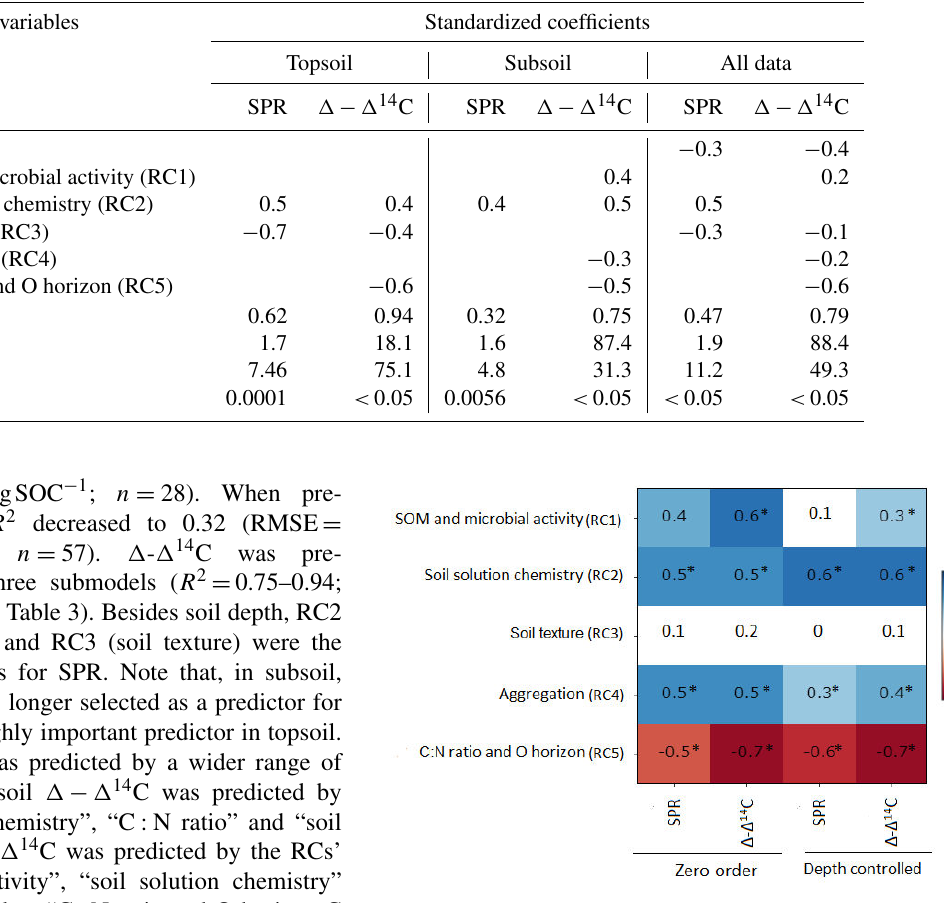
Figure 3. Zero-order and partial correlations displayed as Pear- son’s r between target variables (SPR and (cid:49) − (cid:49) 14 C) and explana- tory variables, controlling for soil depth. Colour indicates the rela- tionship (red is a negative correlation, blue is a positive correlation and white is a weak correlation). The intensity of the colour indi- cates the strength of the correlation. Asterisks indicate that correla- tions are significant at p value <